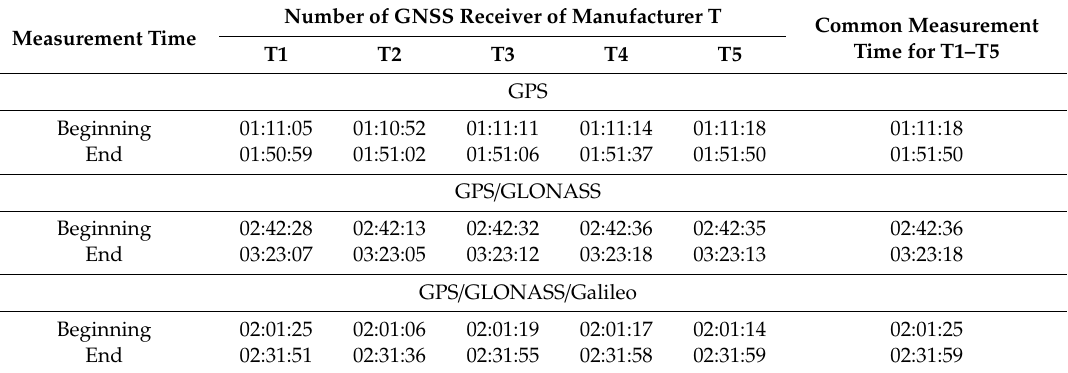
Table 2. Time of starting and finishing measurements by the GNSS receivers (T1–T5), based on which the common time interval, was